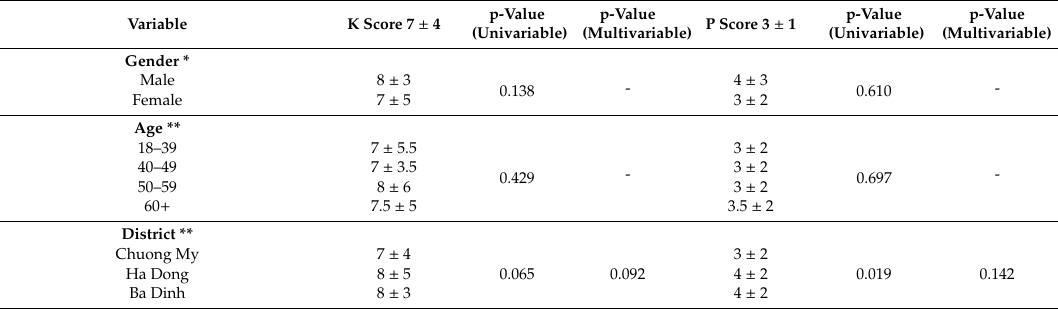
Table 4. Knowledge (K) and practice (P) scores with respect to